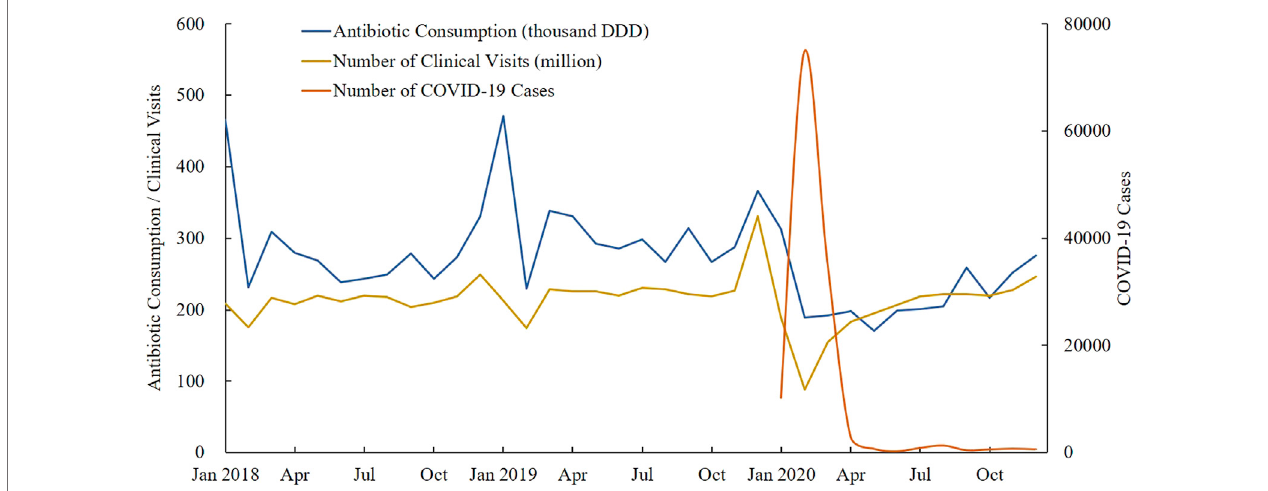
FIGURE 6 | Monthly trend of antibiotic consumption, clinical visits, and number of COVID-19 cases under treatment between January 2018 and December 2020. Note: Data of 24 provinces were involved. DDD, de fi ned daily doses.